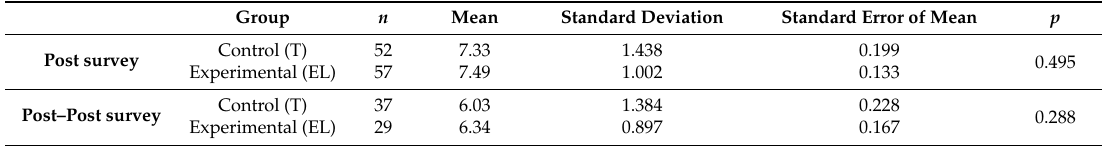
Table 11. Students’ perception of their own